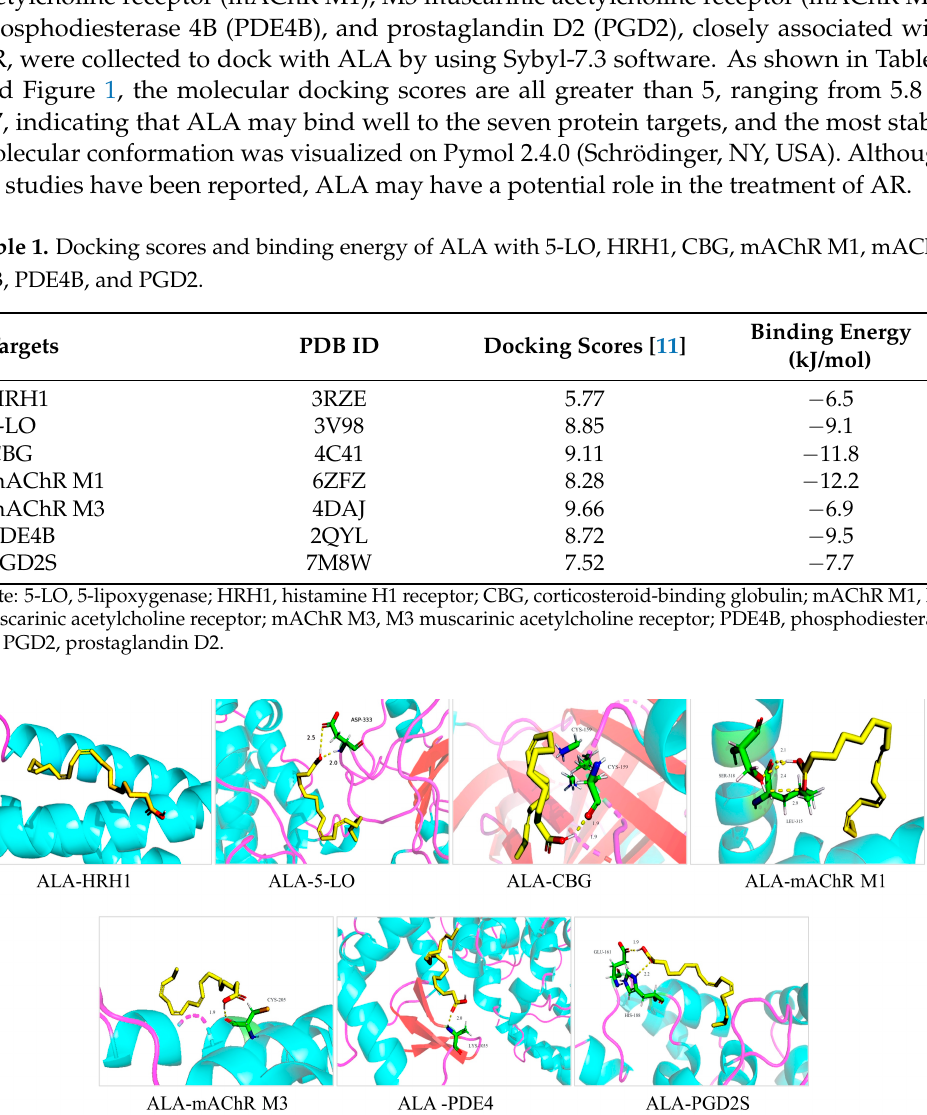
Figure 1. Molecular docking diagram of ALA with 5-LO, HRH1, CBG, mAChR M1, mAChR M3, PDE4 B, and PGD2. 5-LO, 5-lipoxygenase; HRH1, histamine H1 receptor; CBG, corticosteroid-binding globulin; mAChR M1, M1 muscarinic acetylcholine receptor; mAChR M3, M3 muscarinic acetylcholine receptor; PDE4B, phosphodiesterase 4B; PGD2, prostaglandin D2.